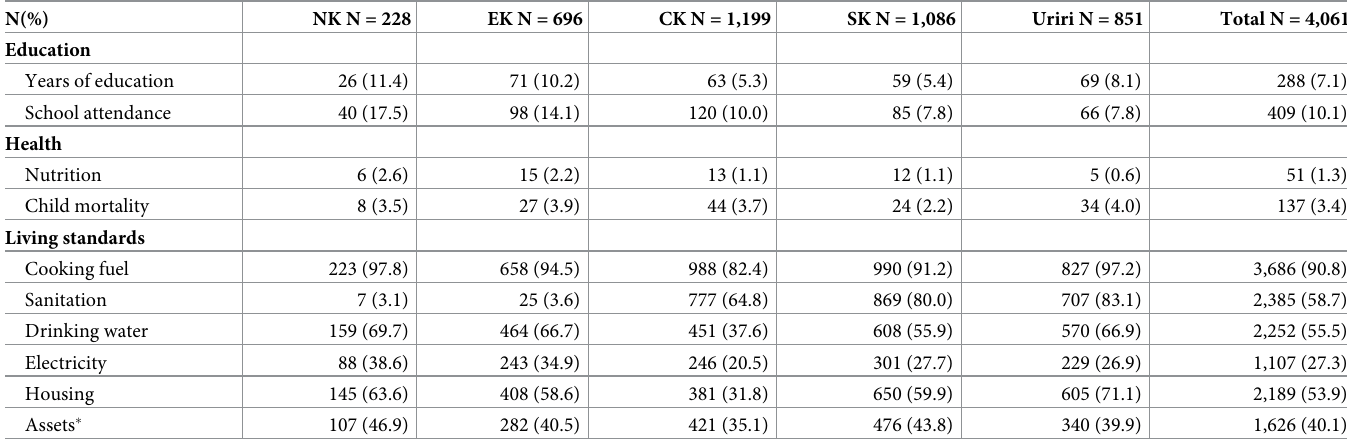
Table 4. Domain areas of deprivation.